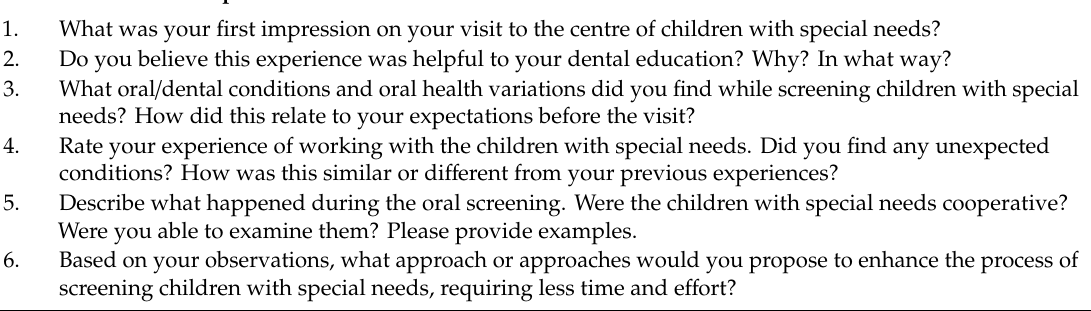
Table 2. The list of the open-ended questions after the fieldwork